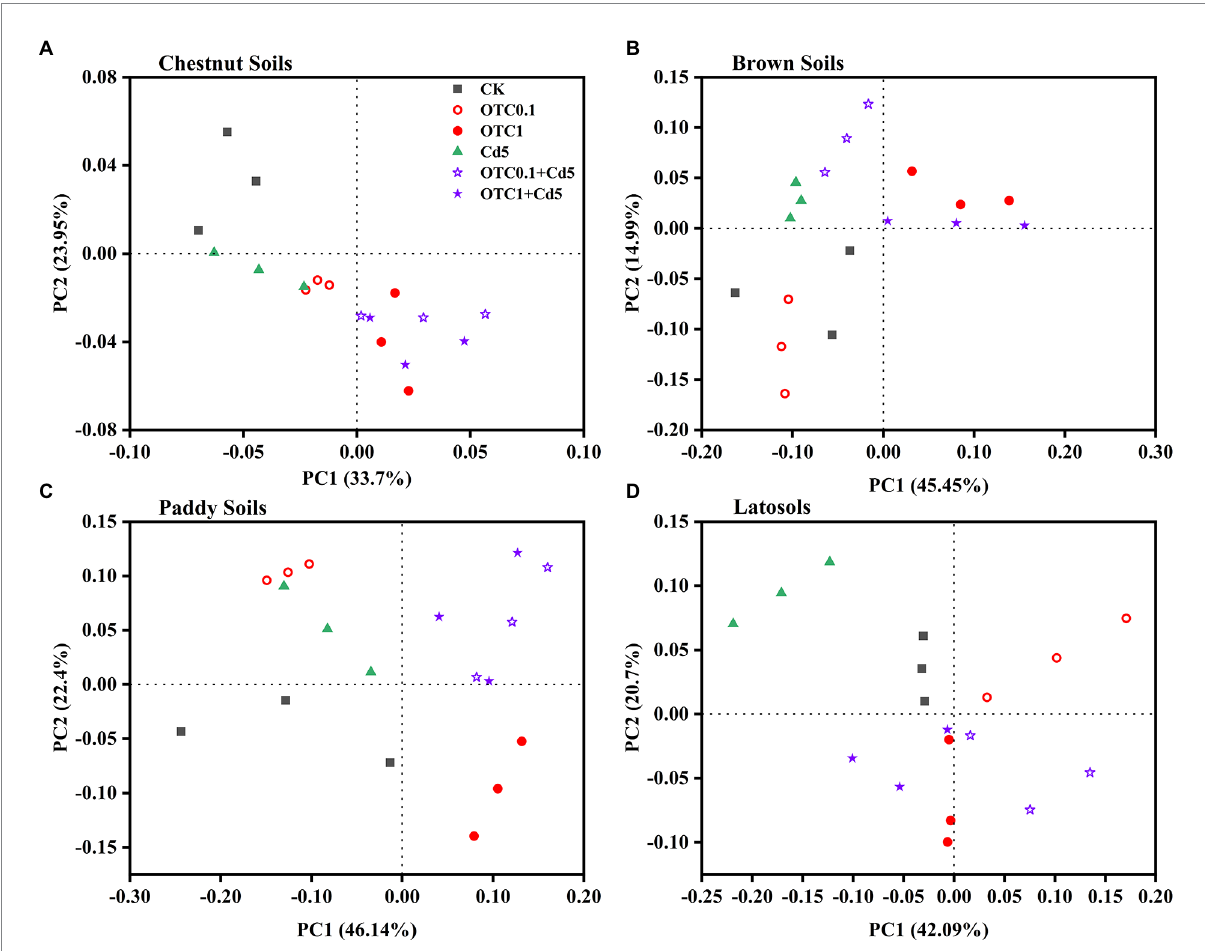
FIGURE 5 Principal coordinate analysis (PCoA) of the Bray–Curtis distance matrix representing differences in the community structure of AOA under CK, OTC0.1, OTC1, Cd5, OTC0.1 + Cd5, and OTC1 + Cd5 treatments in chestnut soils (A) , brown soils (B) , paddy soils (C) , and latosols (D) . CK, control treatment without contamination; OTC0.1, OTC addition at 0.1 mg·kg − 1 ; OTC1, OTC addition at 1 mg·kg − 1 ; Cd5, Cd addition at 5 mg·kg − 1 ; OTC0.1 + Cd5, OTC addition at 0.1 mg·kg − 1 and Cd addition at 5 mg·kg − 1 ; OTC1 + Cd5, OTC addition at 1 mg·kg − 1 , and Cd addition at 5 mg· kg − 1